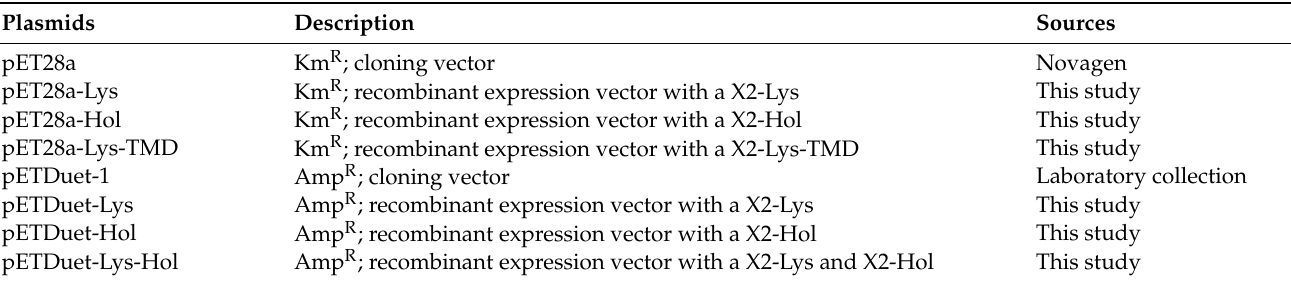
Table 1. Plasmids used in this study.